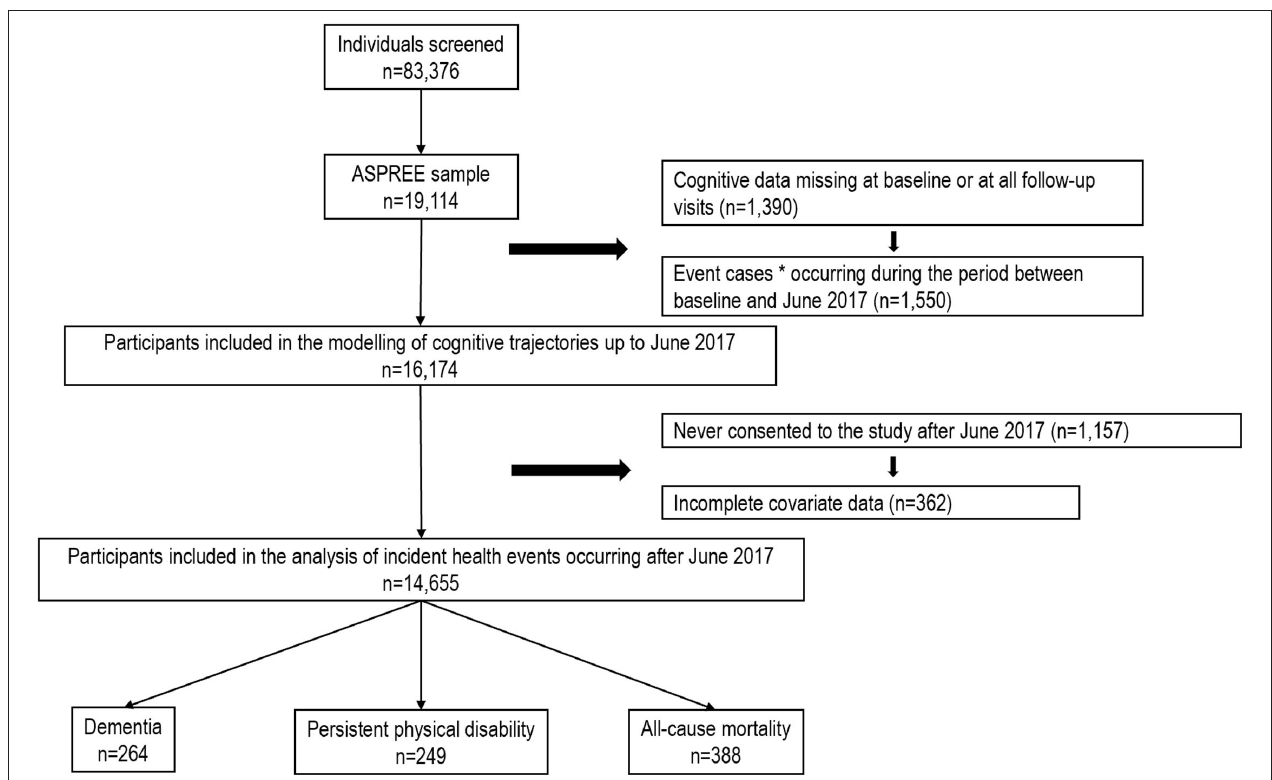
FIGURE 1 | Flow diagram of participants included in the analysis. *Incident dementia, persistent physical disability and all-cause